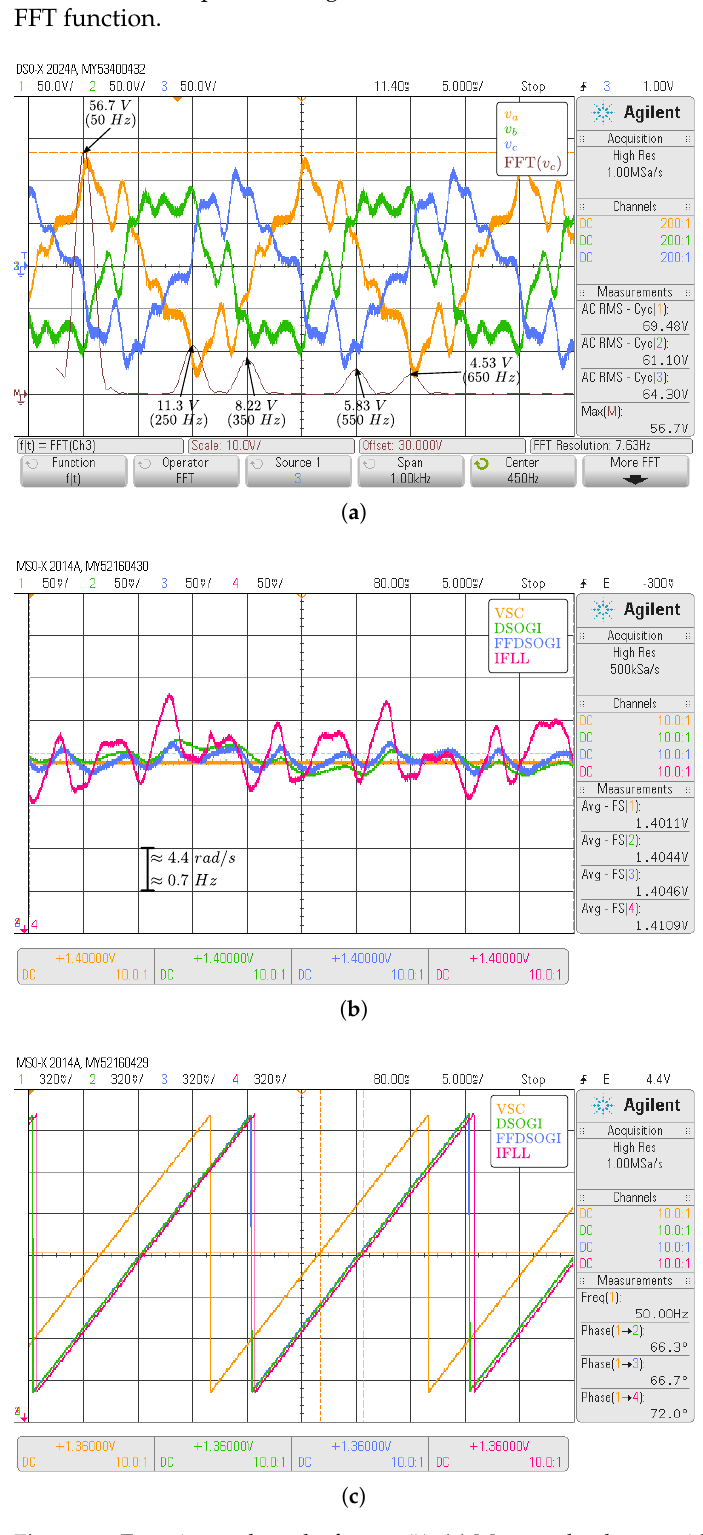
Figure 18. Experimental results for test #1. ( a ) Measured voltages with the FFT of phase v c , ( b ) esti- mated frequency and ( c ) estimated phase